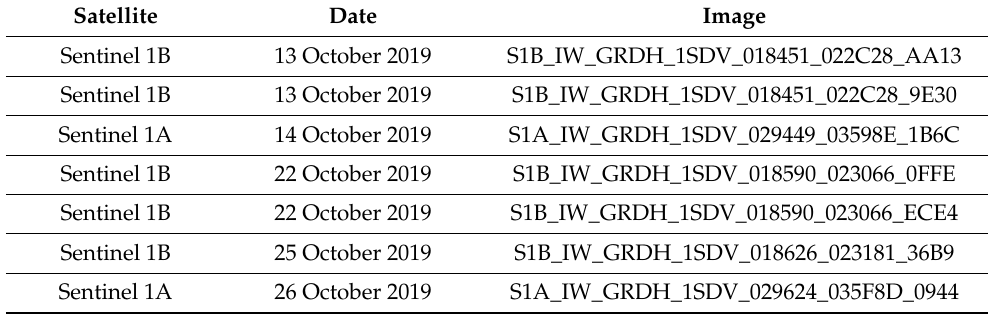
Table 2. List of the Sentinel 1 SAR images used in this study.